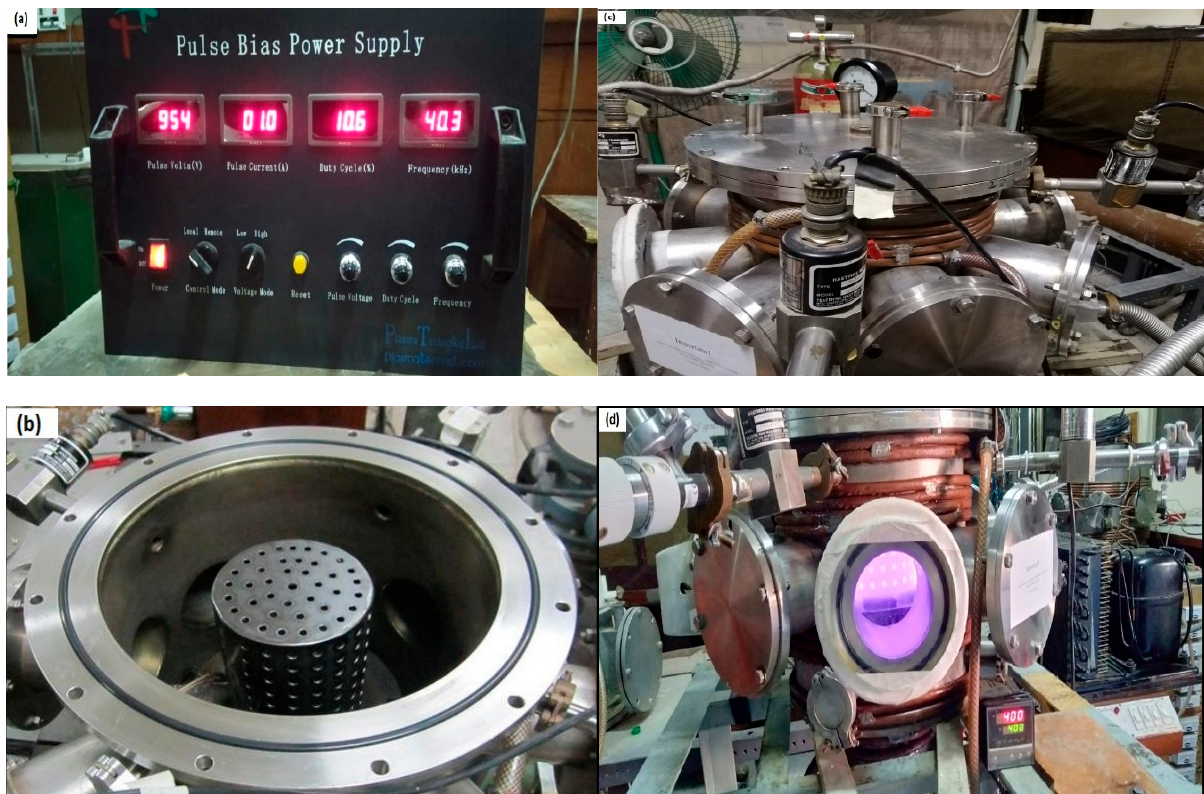
Figure 2. A pictorial view of ( a ) pulsed bias power supply, ( b ) CCPN system without a lid, ( c , d ) CCPN system during plasma treatment.